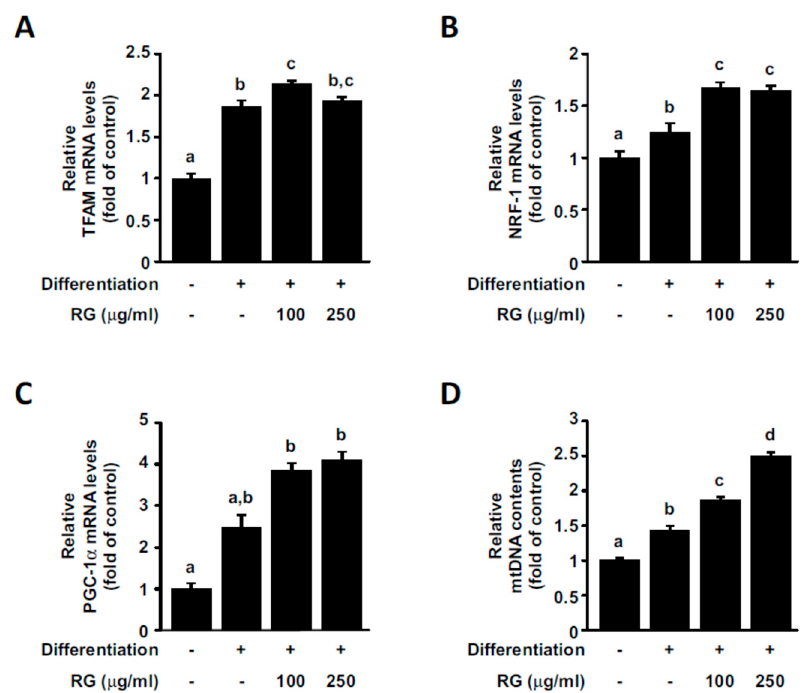
Figure 3. Effects of RG on mitochondrial biogenesis. Cells were induced to differentiate for 2 days, and then cells were treated with 100 or 250 μ g/mL of RG for 48 h. ( A–C ) Relative mRNA expressions of nuclear respiratory factor 1 (NRF-1), mitochondrial transcription factor A (TFAM), and PPAR gamma coactivator 1-alpha (PGC-1 α ) were detected using real-time PCR analysis. The expression levels were normalized to that of GAPDH. ( D ) Mitochondrial DNA (mtDNA) copy number was measured. Data are expressed as mean ± S.D. Bars with different letters mean significant differences from each other (* p < 0.05).